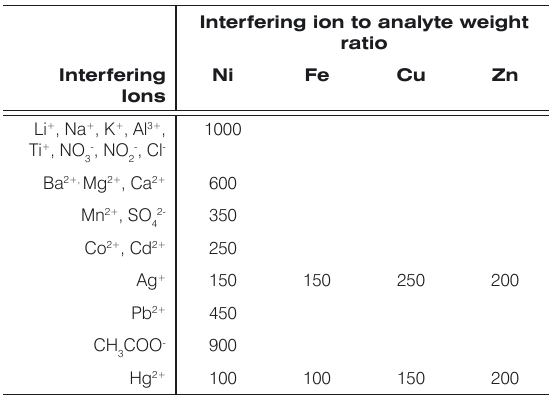
Table 1. Effects of the interferences ions on the recoveries of the examined metal ions Interfering ion to analyte weight ratio Interfering